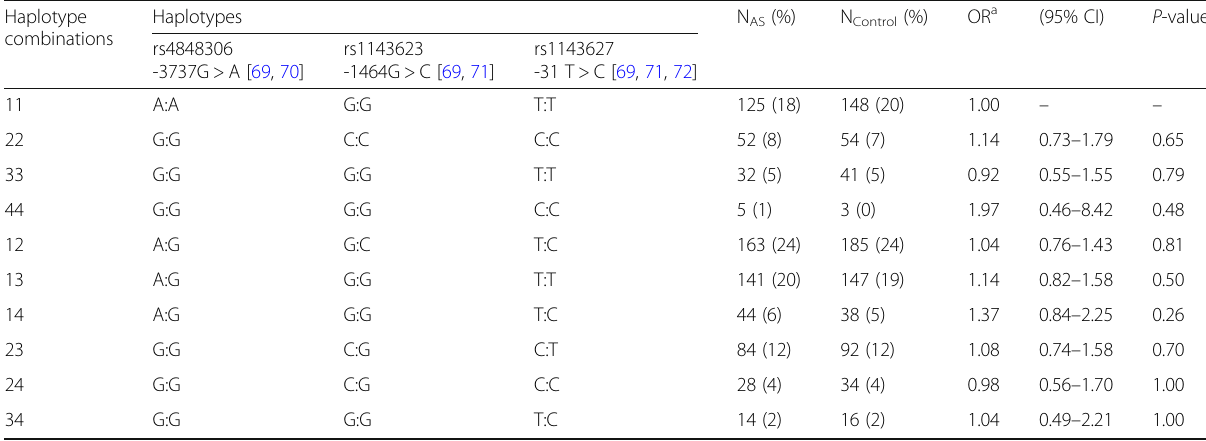
Table 5 Association between IL1B haplotype combinations and risk of ankylosing spondylitis (AS). The haplotype combinations in IL1B described 97% of the genotypes observed Haplotype combinations